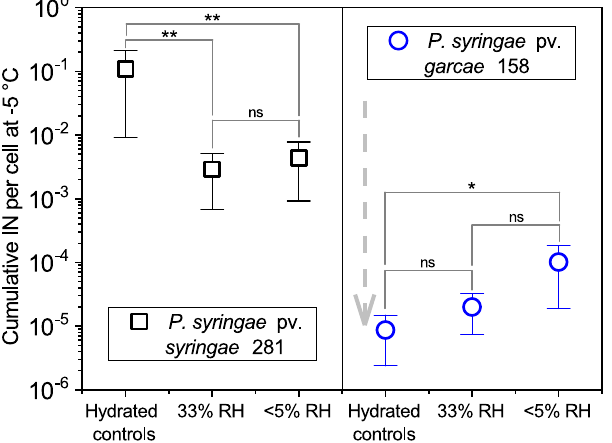
Figure 8. IN activity following desiccation. The concentration of cumulative ice nuclei per cell at − 5 °C of P. syringae pv. syringae 281 presented a significant (p < 0.01) decrease after desiccation at 33% and < 5% RH for 6 days at 20 °C compared to its hydrated controls. Surprisingly, P. syringae pv. garcae 158 suffered a large reduction in IN in relation to its typical values (repeatedly measured as 10 − 2 –10 − 1 per cell at − 5 °C, Fig. 1) even while hydrated, as indicated by the downwards grey arrow. Error bars denote standard deviations of the means (n = 6). Based on Bonferroni-corrected Mann-Whitney U tests, significantly different values are marked as * (p < 0.05) or as ** (p < 0.01), and non-significant differences as